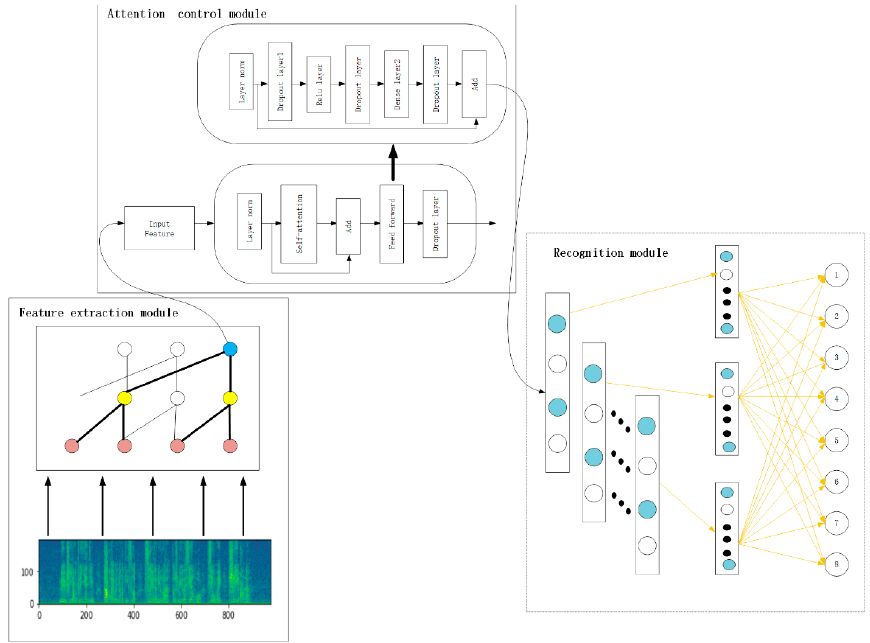
Figure 1. The overall framework of proposed TCDCN model.